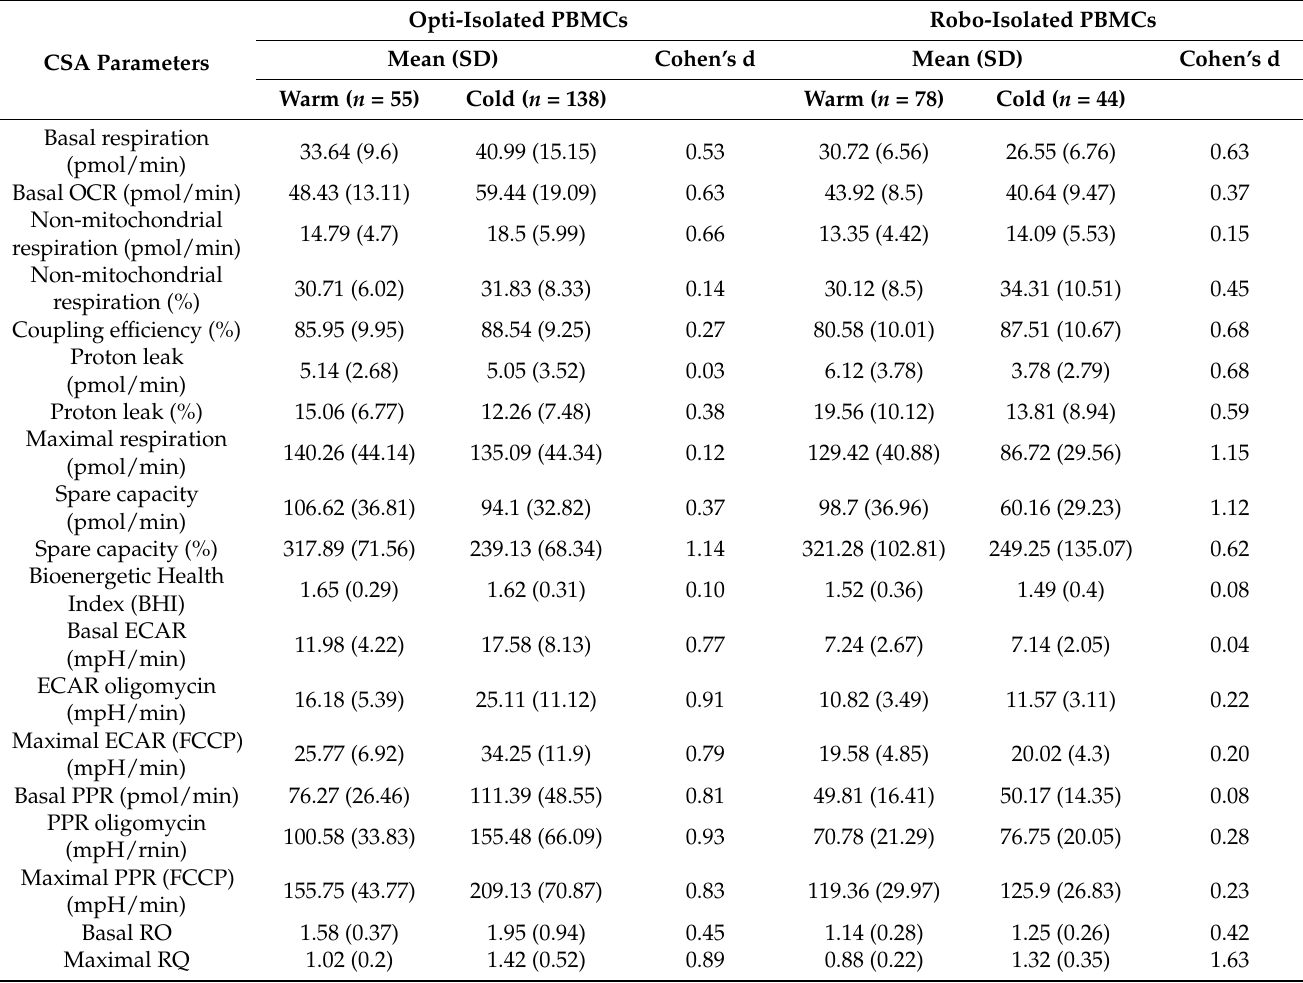
Table 5. Mean, standard deviation and Cohen’s d of all relevant parameters after comparing warm and cold periods of the year in Opti- and Robo-isolated